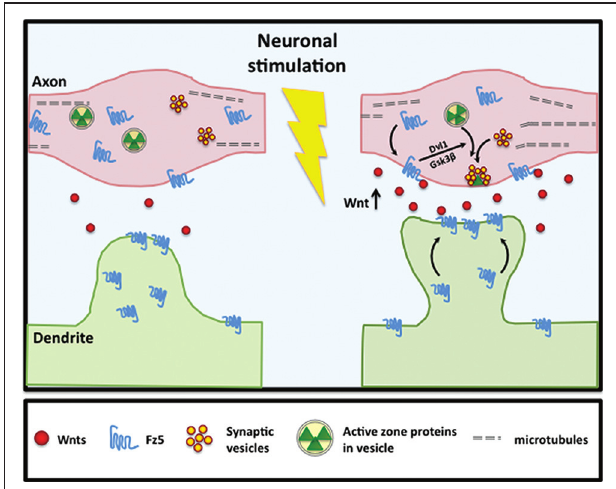
FIGURE 3 | Neuronal activity stimulates Fz5 mobilization to synapse cell surface . Neuronal activity stimulates Wnt expression and/or release. Activity-dependent Wnt release subsequently induces Fz5 cell surface expression at synaptic sites. In hippocampal neurons, activity-dependent Fz5 mobilization through Wnt signaling is required for activity-mediated synapse